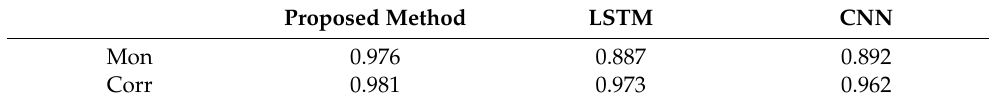
Table 4. The monotonicity and tendency of HI.